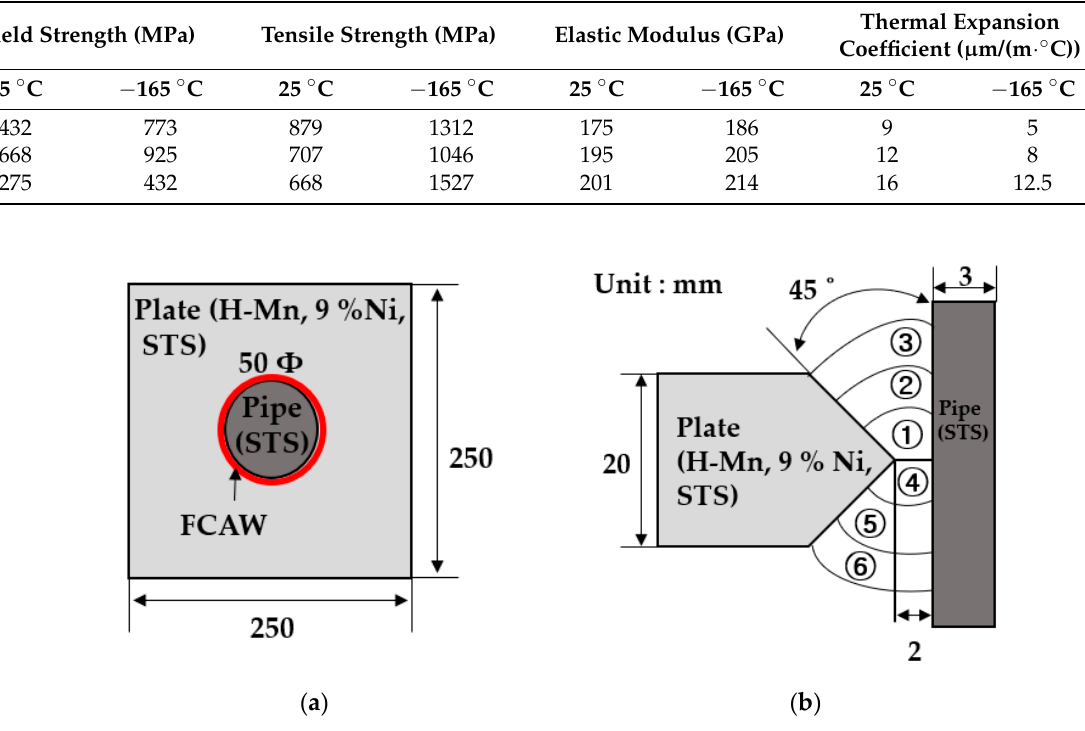
Table 2. Mechanical properties of the cryogenic steels. Table 3. Welding